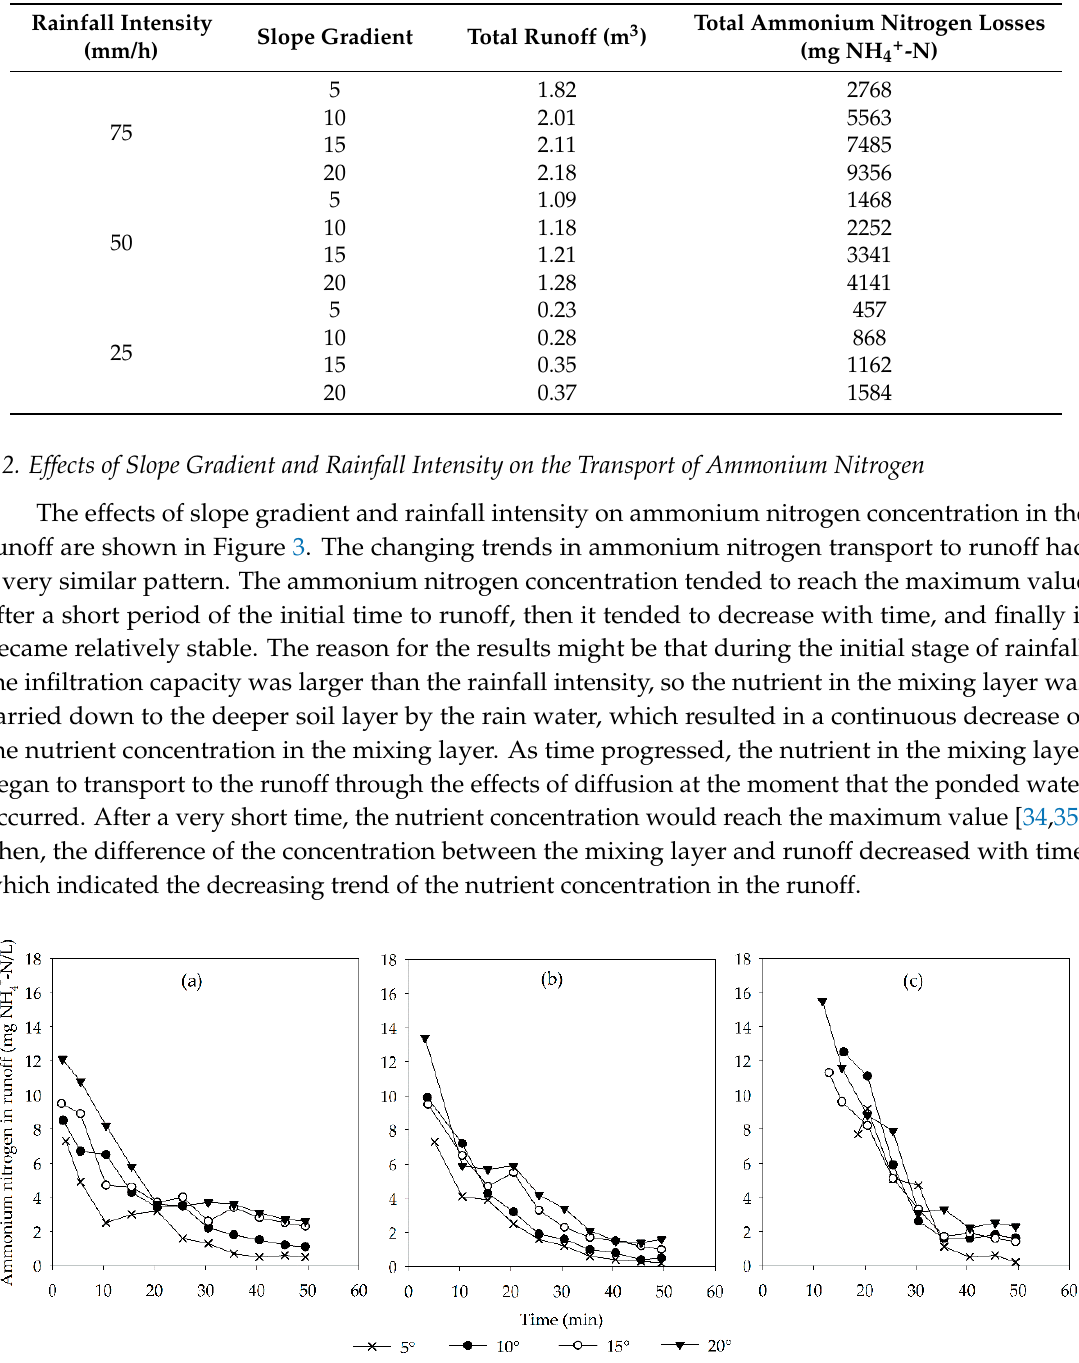
Figure 3. The ammonium nitrogen (NH 4+ -N) concentration in runoff over rainfall time under different slope gradients and different rainfall intensities: ( a ) 75 mm/h, ( b ) 50 mm/h ( c ) 25 mm/h. The slope gradient had effects on the processes of ammonium nitrogen transport to